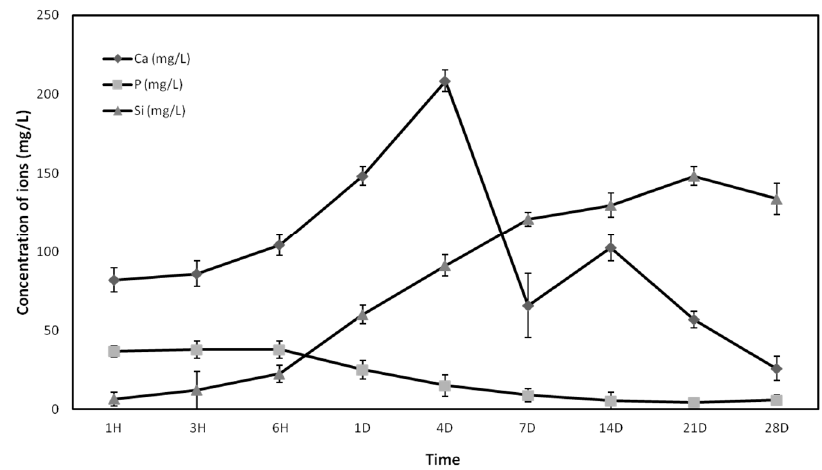
Figure 1. Changes of Si, Ca, and P concentrations of the growth medium (GM) after inmersion of Nurse’s A-phase ceramic for various times.